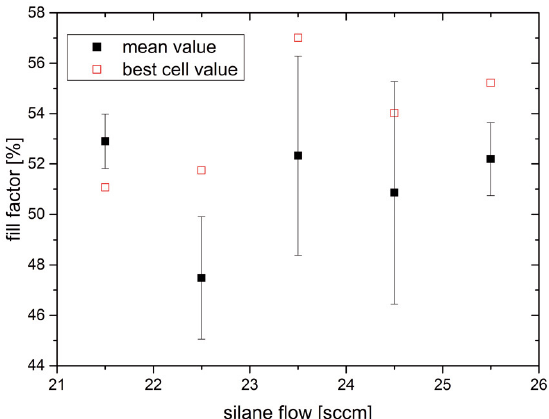
Fig. 3. Fill factor values in relation to the silane flow of single µ c-SiGe:H